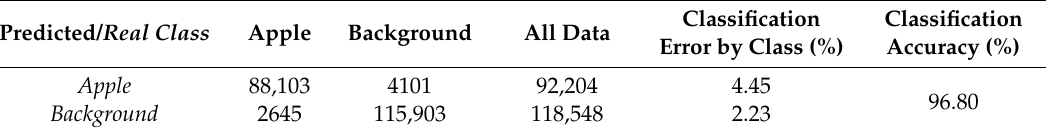
Table 9. Confusion matrix and accuracy of the segmentation algorithm using color histogram models on the testing